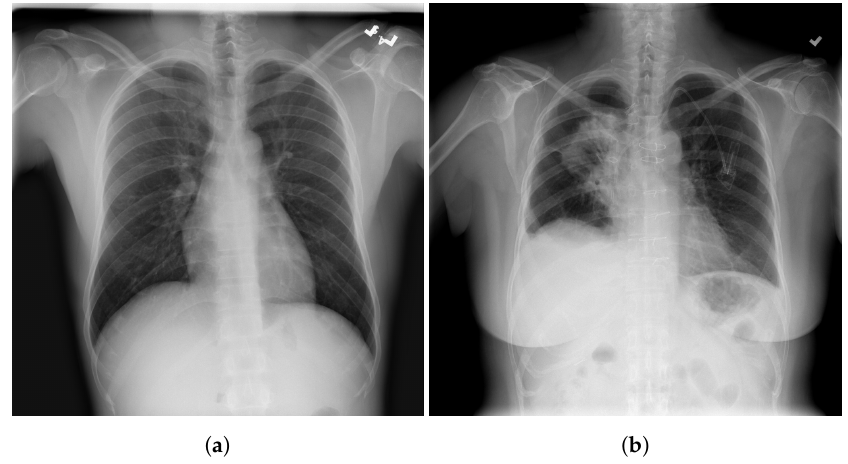
Figure 8. Examples of RSNA images: ( a ) normal; ( b ) lung opacity [29].